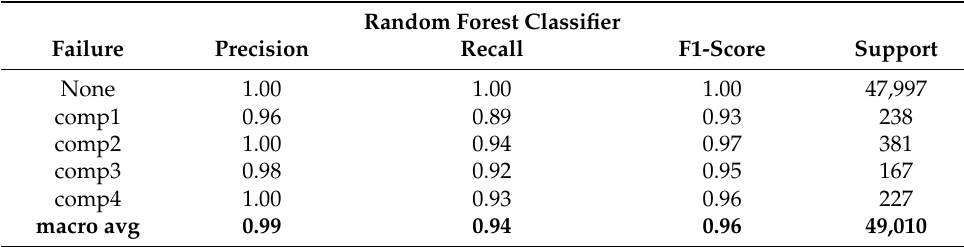
Table 3. Replicated predictive results using RF classifier. Results show that RF classification reach superior results in terms of classifying the failed